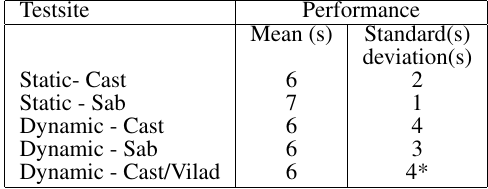
Table 1. Mean and standard deviation of time period between consecutive data